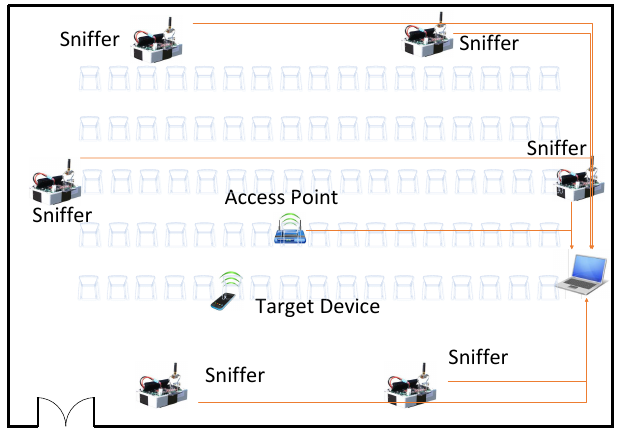
Figure 1. Structure of the TDOA-based passive WiFi localization system.